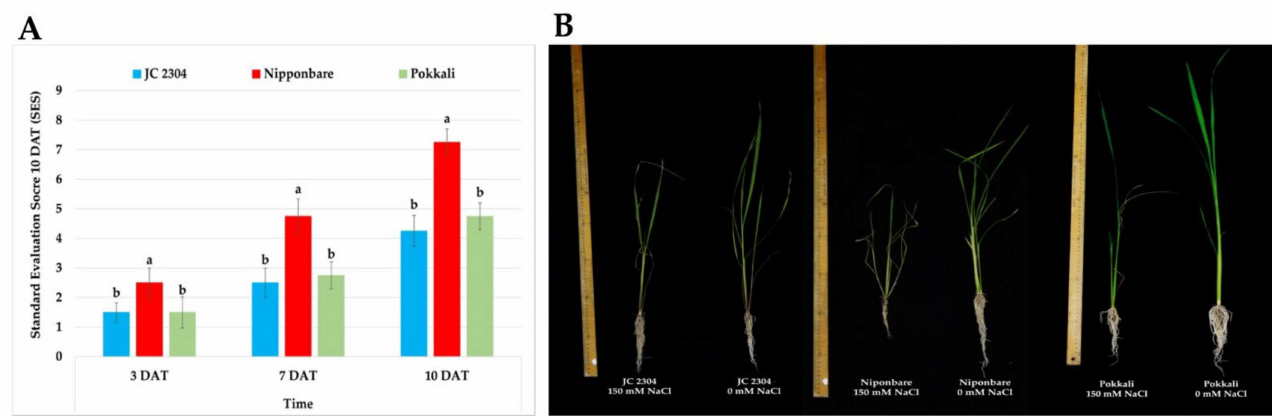
Figure 3. Salinity tolerance of wild and cultivated rice under 150 mM NaCl treatment. ( A ) SES of wild rice JC 2304 and two cultivated rice cultivars (salt-sensitive cultivar Nipponbare and salt-tolerant cultivar Pokkali). ( B ) Phenotypes of wild and cultivated rice under 150 mM NaCl treatment for 10 days. Data represent the means ± SE ( n = 8). Values labelled with different letters are significantly different at p < 0.05, based on the Turkey HSD test. DAT—day after